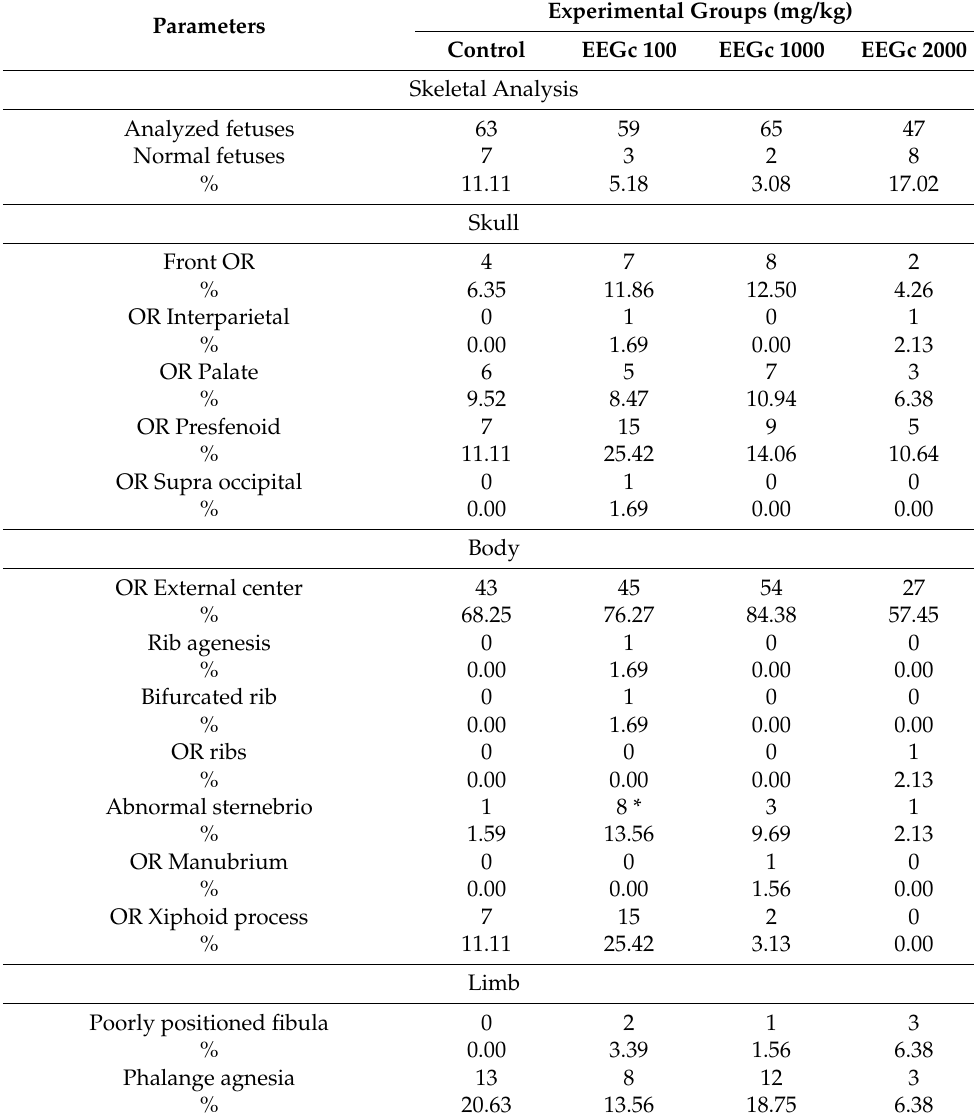
Table 6. Skeletal malformations found in the offspring of females treated with the G. celosioides ethanolic extract